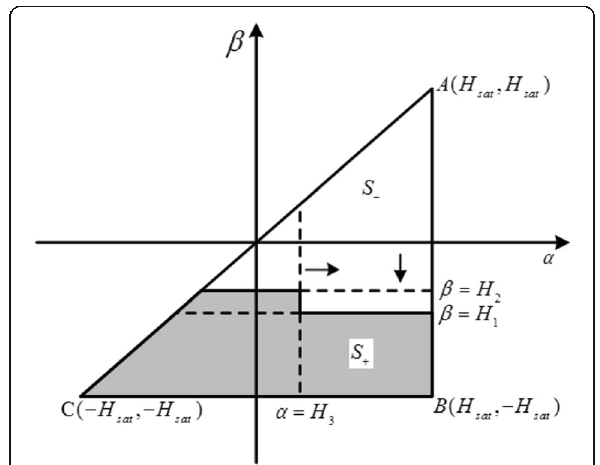
Fig. 2 A typical Preisach